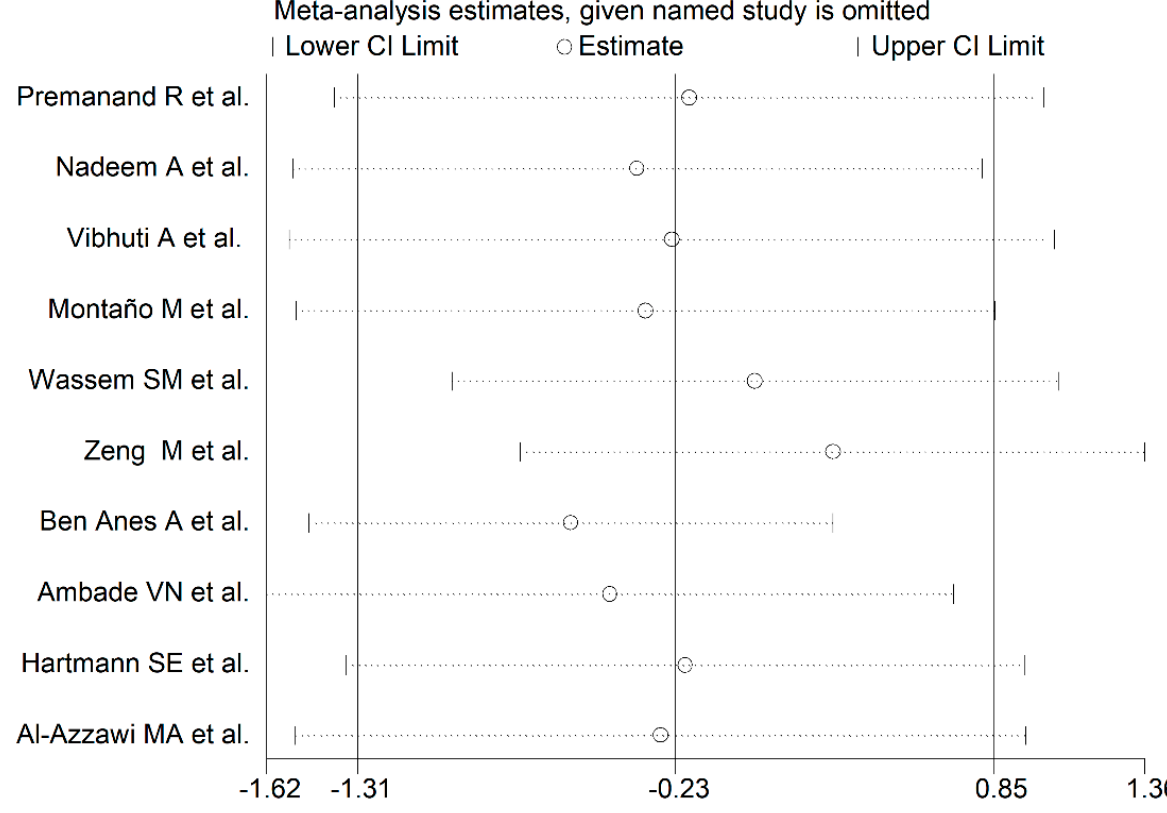
displayed effect size (hollow circles) corresponds to an overall effect size computed from a meta-analysis which excluded